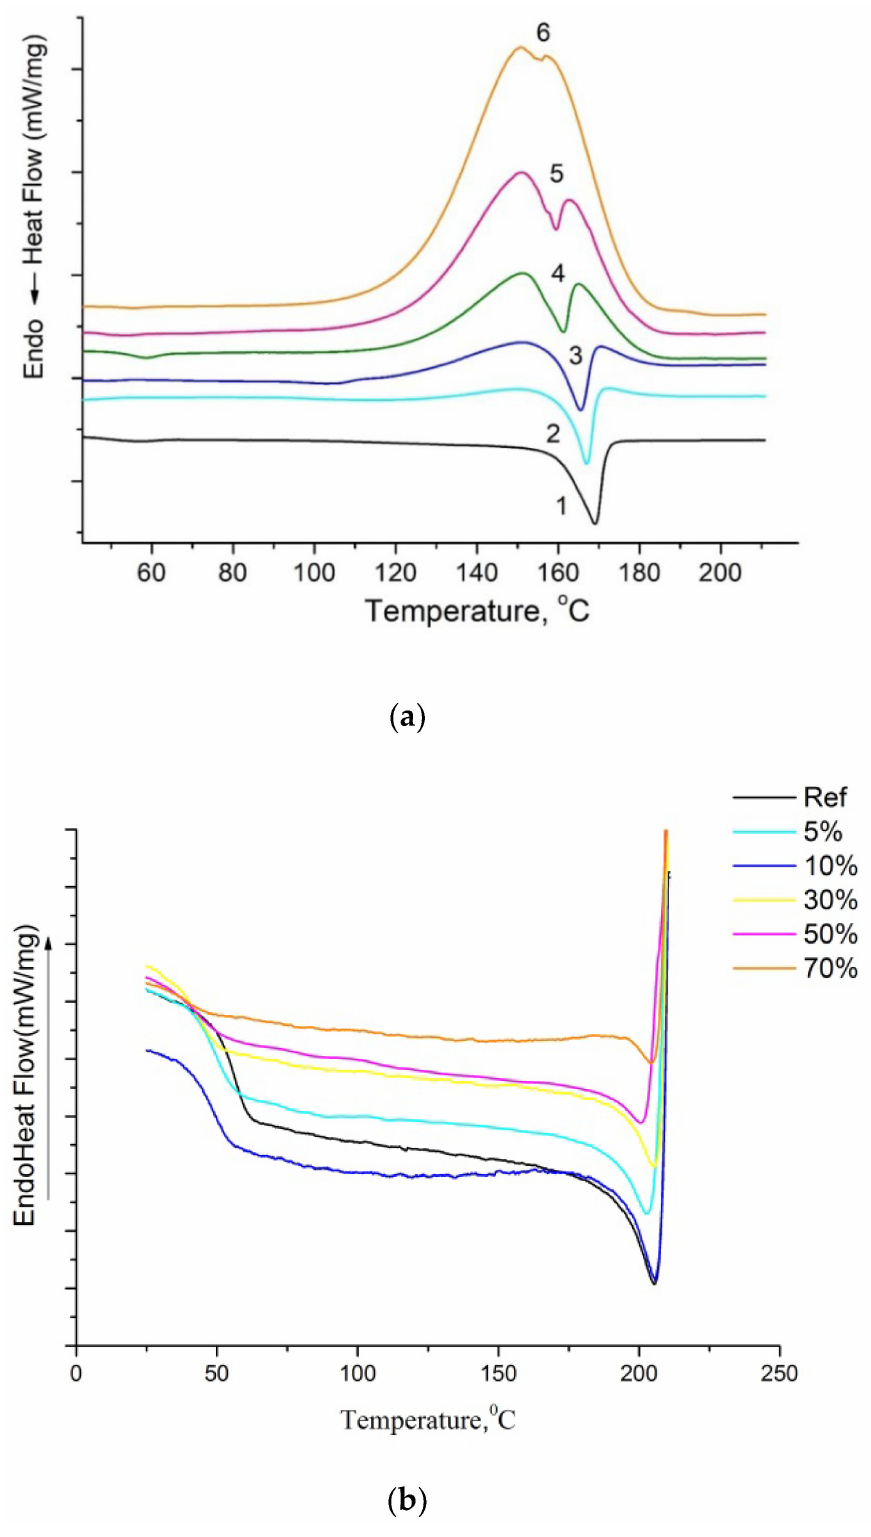
Figure 8. ( a ) DSC thermograms of the first heating for pristine PLA and PLA + OTOA (5–70%) film samples: PLA (1), PLA +5% OTOA (2), PLA +10% OTOA (3), PLA +30% OTOA (4), PLA +50% OTOA (5), PLA +70% OTOA (6). ( b ) DSC thermographs of colling the samples after the first